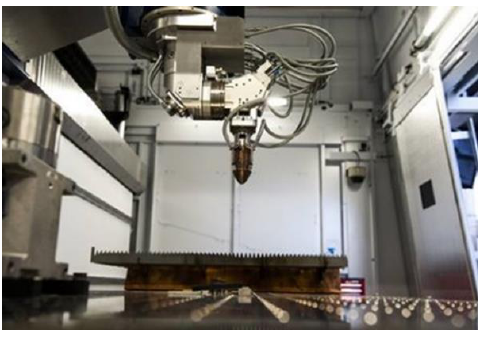
Figure 4. Set-up of 3D robot assisted TRUMPF TruLaser Cell 7040 5kW cw-CO2 laser system.